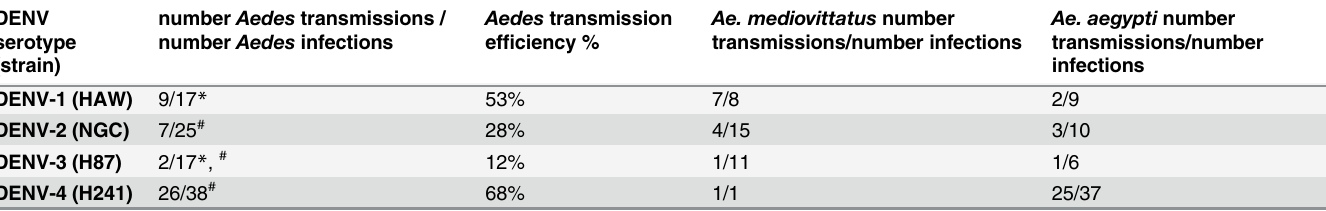
simultaneous 95% con fi dence intervals.